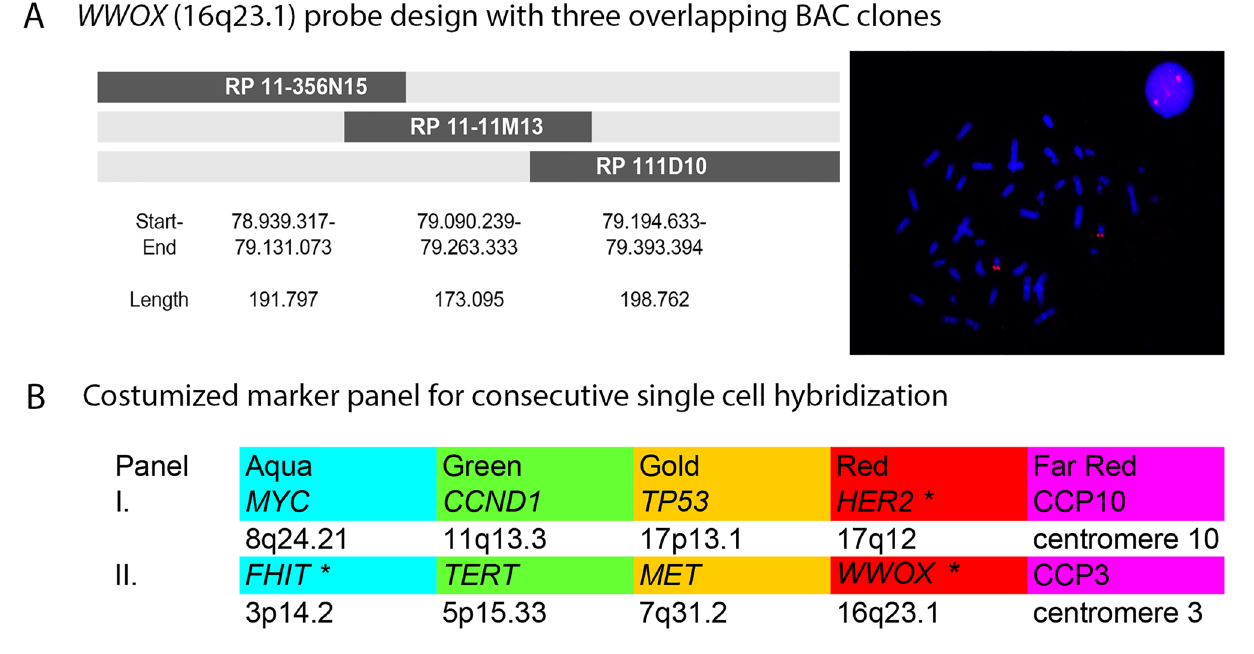
Figure 1. ( A ; left side) Scheme of overlapping WWOX BAC clones, which are subsequently combined to create the WWOX probe, showing clone name, start, end and length of clone. Clones were fluorescently labeled by nick translation and tested for correct location and signal strength and background before they were combined. ( A ; right side) Lymphocyte cell and metaphase spread hybridized with BAC clone for the WWOX probe. Signals appear within interphase nucleus and in metaphase spreads on chromosome arm 16q consistent with the locus for the WWOX gene. ( B ) Complete marker panels with indication of color and chromosomal localization. *Stars indicate genetic markers that have previously not been investigated in